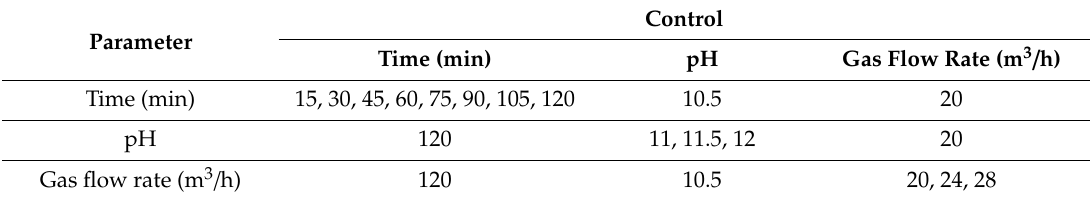
Figure 1. Schematic diagram of stripping components. 1. Alkaline solution peristaltic pump; 2. Biogas slurry peristaltic pump; 3. Liquid flowmeter; 4. Gas outlet; 5. Absorption tank; 6. Neutralization tank; 7. Absorption plant; 8. Alkaline solution tank; 9. Aeration device; 10. Stripping tower; 11. Gas flowmeter; 12. Aeration fan; 13. Heating rod; 14. pH meter; 15. Stirrer; 16. Temperature thermocouple; 17. Liquid storage tank. Table 1. Scheme of single-factor ammonia stripping experiment.